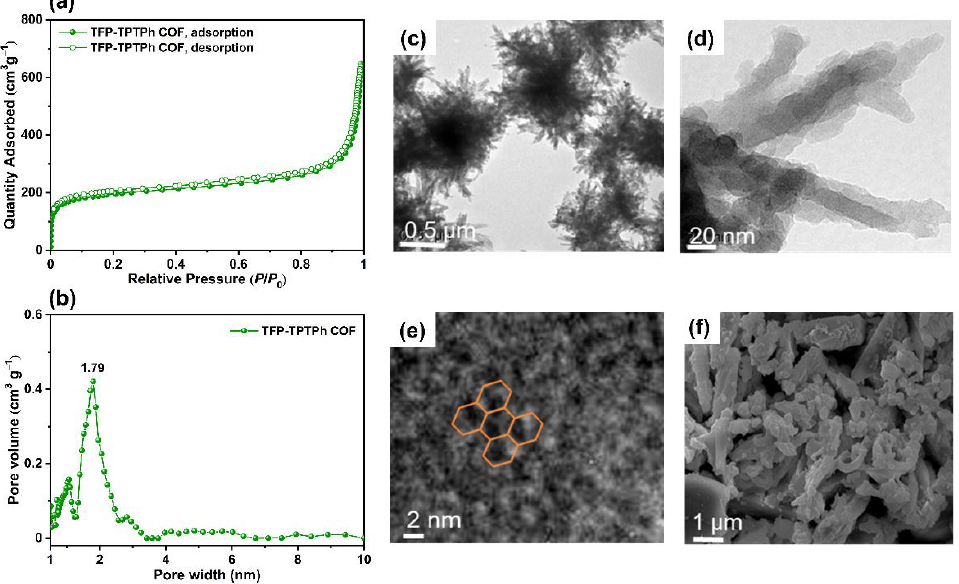
Figure 2. ( a ) N 2 sorption isotherm recorded at 77 K of TFP-TPTPh COF. ( b ) Pore size distribution of TFP-TPTPh COF. ( b – e ) TEM images of TFP-TPTPh COF. ( f ) FE-SEM images of TFP-TPTPh